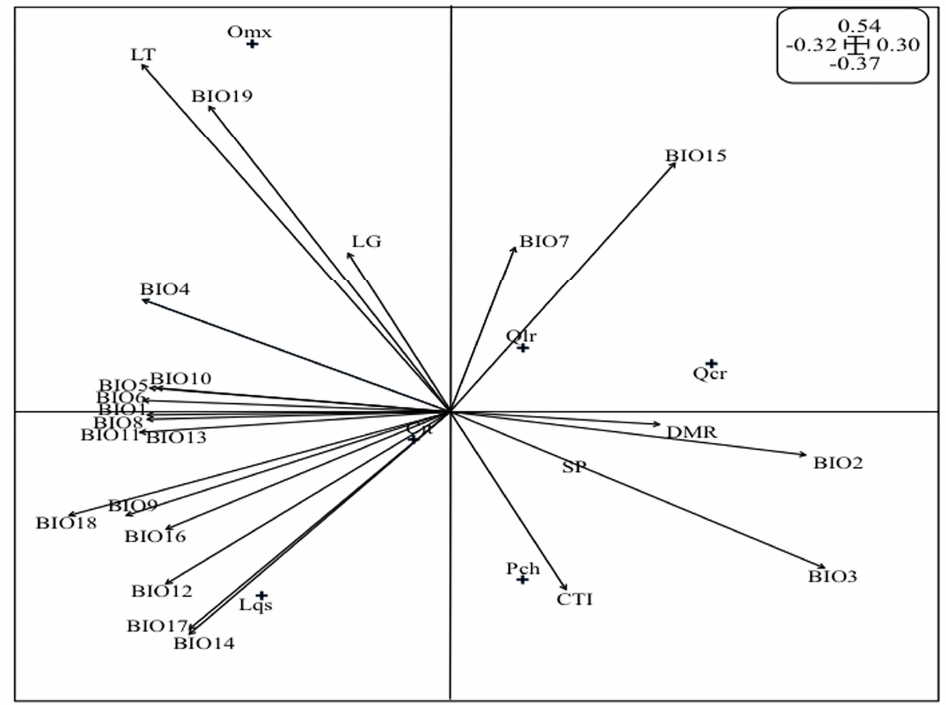
Figure 5. Ordination diagrams on the first two axes of outlying mean index analysis (OMI). The origin of the biplot represents the most general conditions based upon all environmental variables used in the model. Environmental variables are depicted as vectors. The length of the arrows describes the relative importance of each analyzed variable, and the direction indicates how well correlated the environmental variable is with each axis. See Table 1 for the abbreviation of the